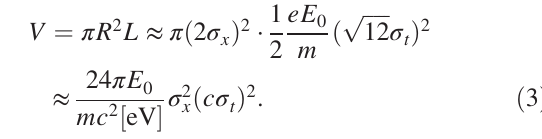
FIG. 3. The optimal emittances as a function of bunch length for a final beam size of σ x ≤ 25 μ m (blue) and σ x ≤ 100 μ m (red), respectively.